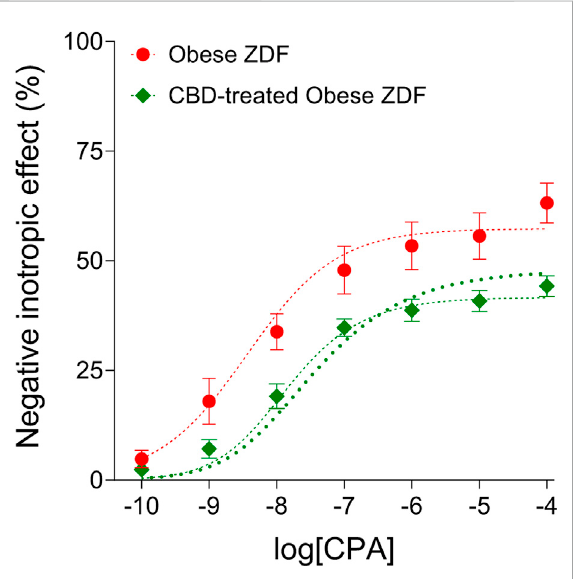
The direct negative inotropic effect of CPA in isolated and paced atria of obese type Zucker Diabetic Fatty (ZDF) rats, without or with a previous in vivo cannabidiol (CBD) treatment. The x -axis denotes the common logarithm of the molar CPA concentrations (in the bathing medium), and the y -axis indicates theeffect(asapercentage decreaseintheinitialcontractileforce). The symbols show the responses to CPA averaged within the groups (±SEM). The thinner and the thicker dotted curves denote the model of the receptorial responsiveness method (RRM) (Eq. 2) fi tted in a global plus robust manner and in an individual plus ordinary way, respectively. CPA: N 6